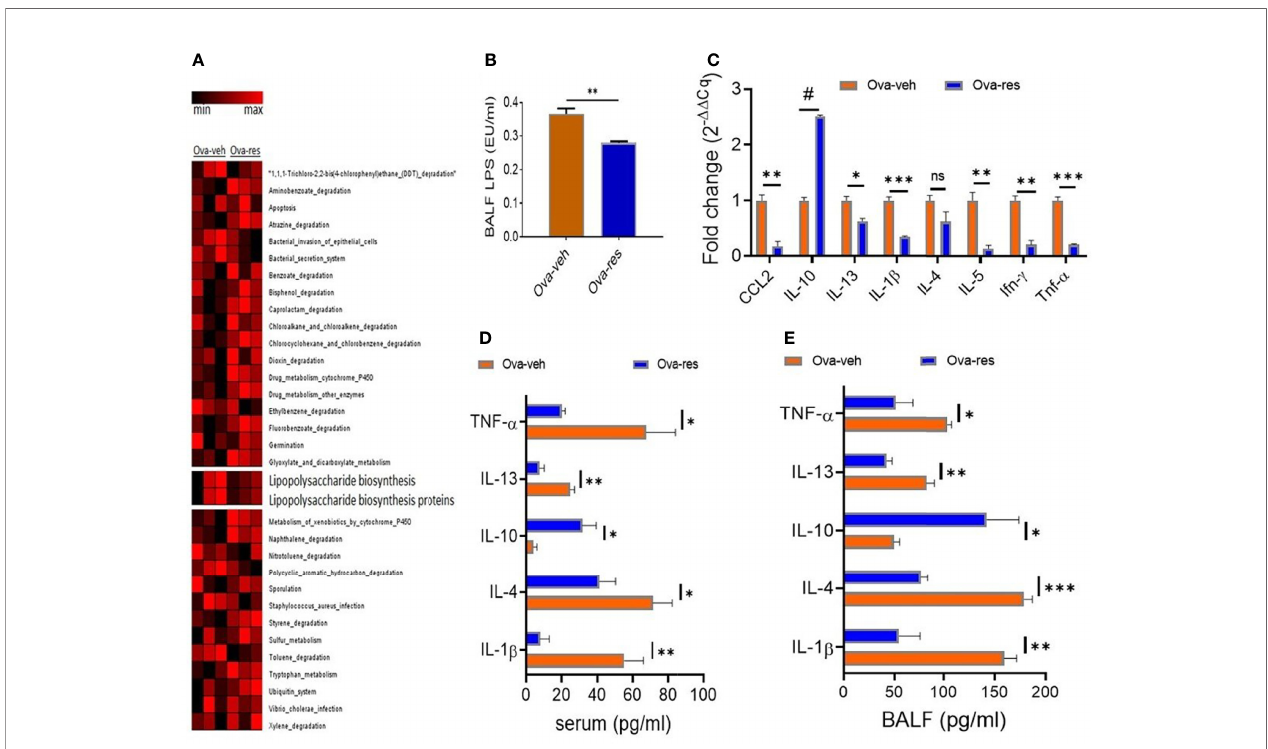
FIGURE 4 | Effect of resveratrol on LPS metabolism and cytokine production. OVA and RES treatments were performed as described in Figure 1 legend. (A) Heat map showing the predicted metagenomic functions of lung microbiota between Ova-veh and Ova-res group. The predicted biological functions were normalized to the mean OTUs of naïve group. (B) LPS concentrations in bronchoalveolar lavage fl uid (BALF) were measured in Ova-veh and Ova-res groups. (C) RT-qPCR assay to measure gene expression of in fl ammatory and anti-in fl ammatory cytokines in the isolated mononuclear cells from mouse lungs of Ova-veh and Ova-res groups. ELISA measurements of different cytokine levels in the serum (D) and BALF (E) of OVA-exposed mice treated either with VEH or RES. Vertical bars in all panels represent Mean+/-SEM data from groups of 5 mice. In panel (A) , 1 mouse out of 5 in Ova-veh and Ova-res groups were excluded by Nephele setting). ns, not signi fi cant, *p<0.05, **p<0.01, ***p<0.001, #